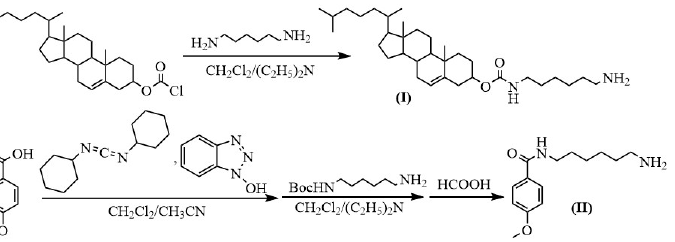
Figure 2. Schemes of the syntheses of amino-modi fi ed cholesterol ( I ) and N -(6-aminohexyl)-4-meth- oxybenzamide ( II ). Boc— tert -butyloxycarbonyl. methoxybenzamide ( II ). Boc— tert